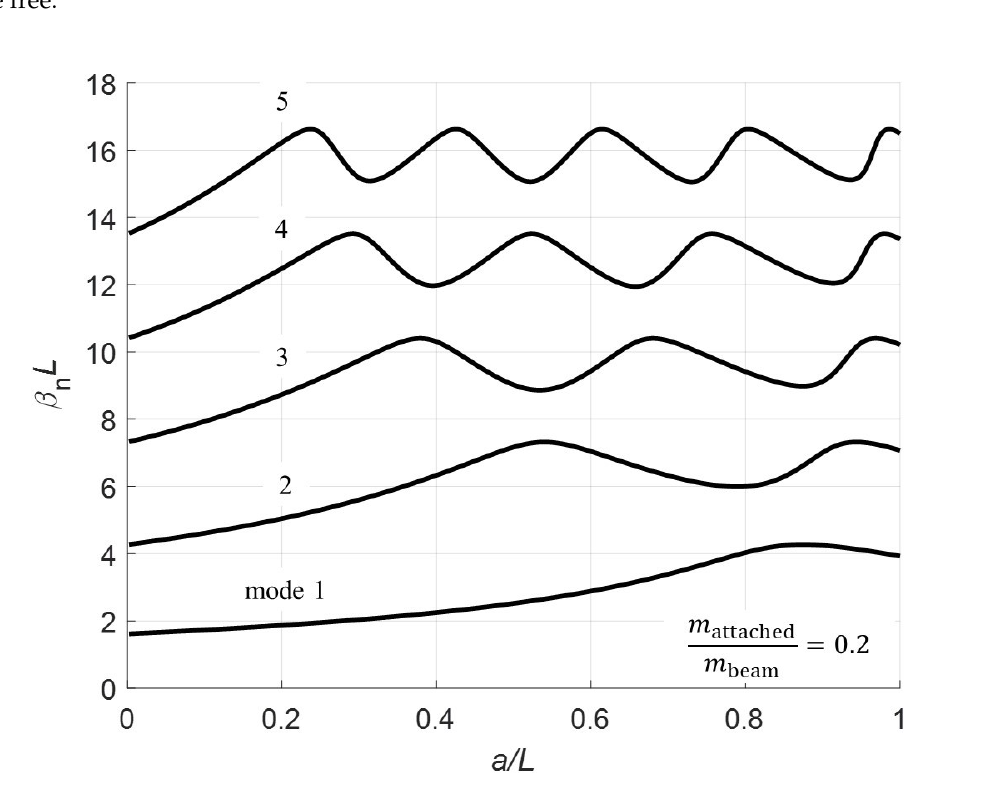
Figure 2. Eigenvalues of first 5 modes, m attached